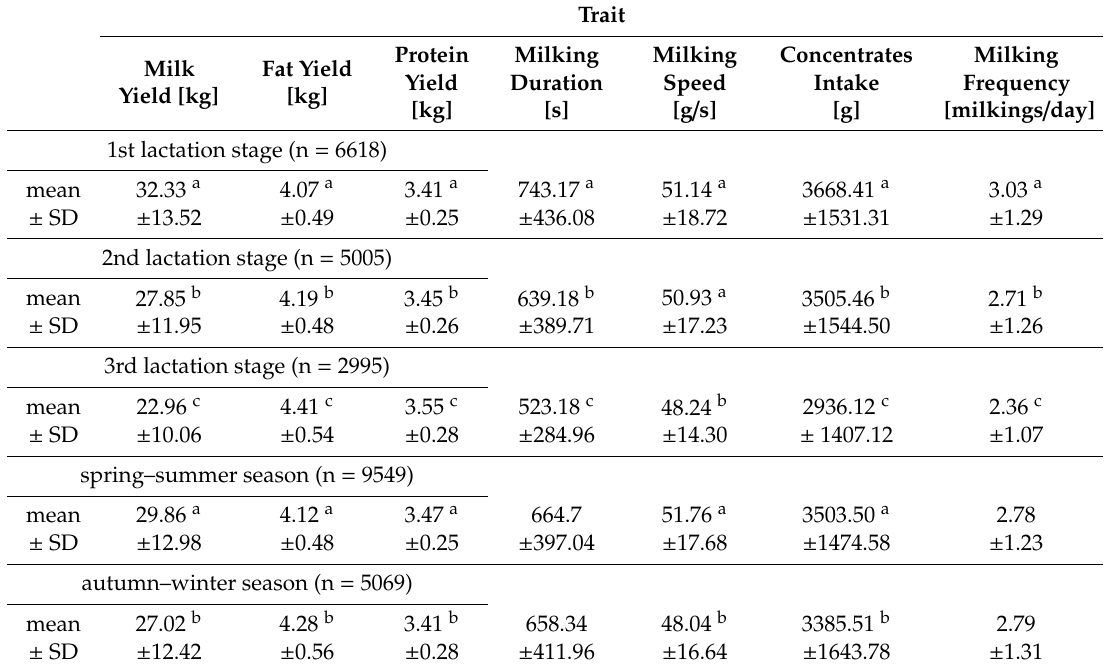
Table 8. Means and standard deviations (SD) of the considered traits for daily milkings in the groups designated by lactation stage, calving season and time of day.